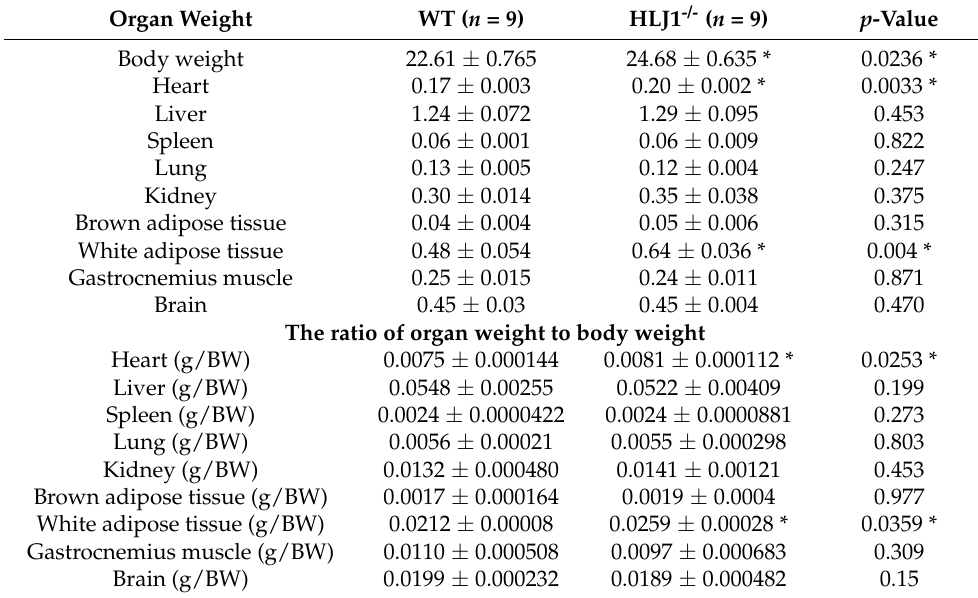
Table 1. Body and tissue weights of WT and HLJ1 -/- mice.